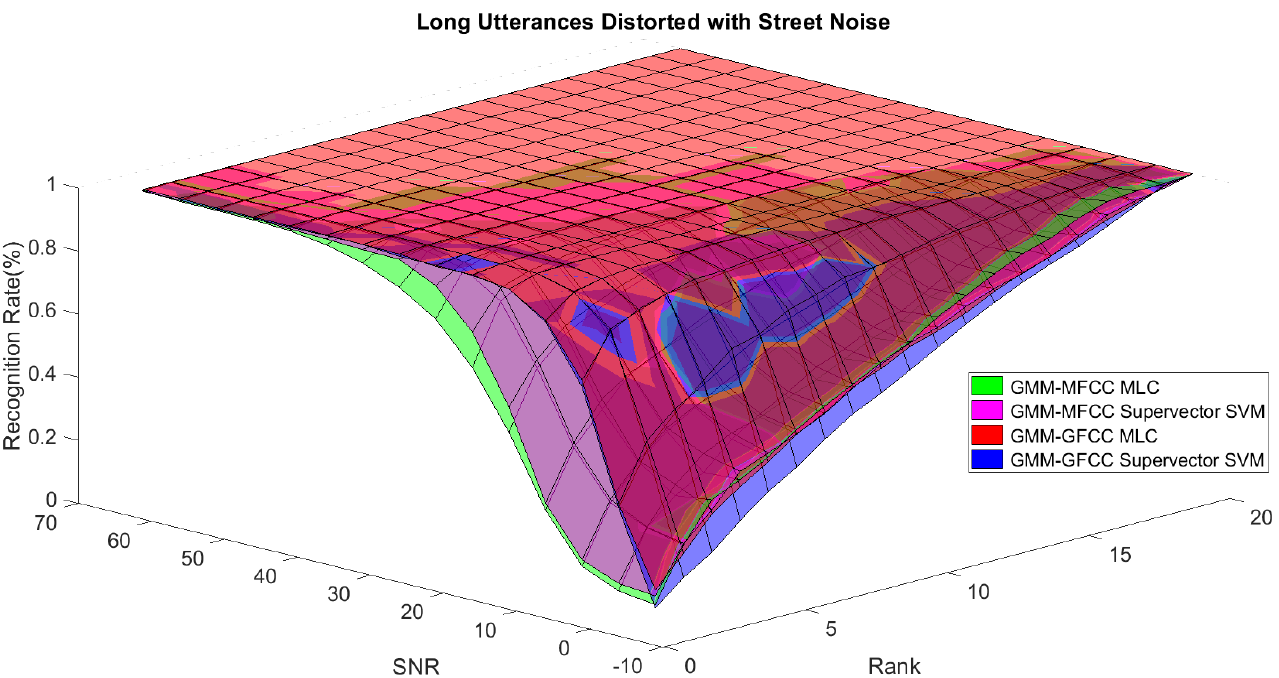
Figure 18. The 3D surface of the recognition rates for the base classifiers on long utterances distorted with street noise.